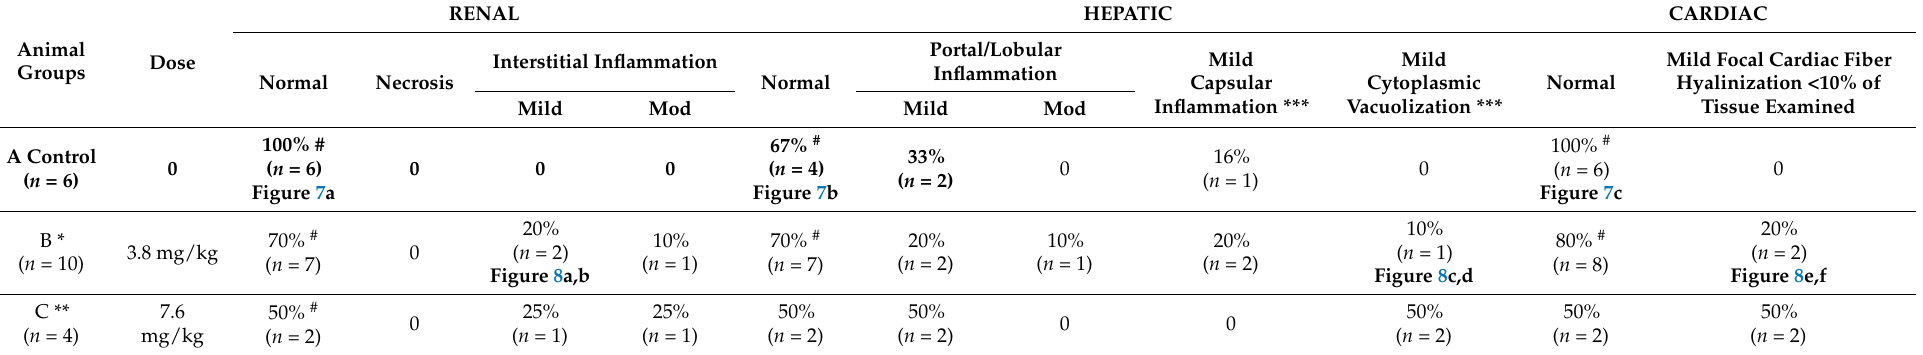
Table 8. Histological findings in sub-acute toxicity study with of the doses of 3.8 mg/kg and 7.6 mg/kg ( n =